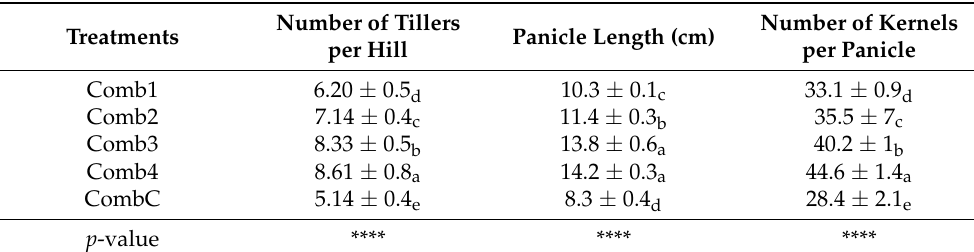
Table 4. Effect of different combinations treatments on the growth attributes of rice grown in Cd contaminated soil under large-scale field